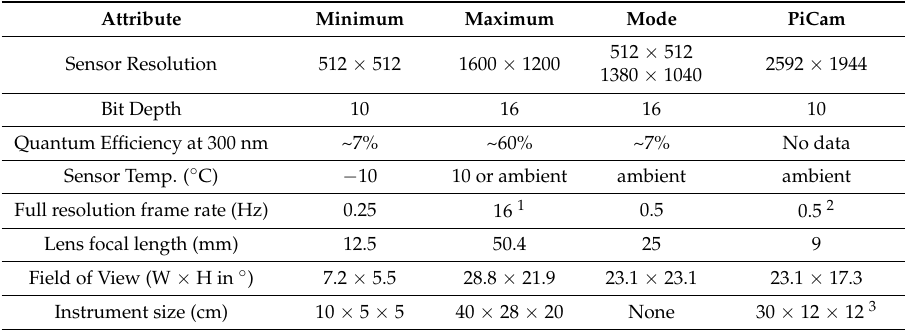
Table 1. A summary of key UV camera specifications from a previous inter-comparative study into the relative performance of seven such units, which have been applied in volcano monitoring [33]. For these seven systems, the maximum, minimum, and mode value of each parameter are supplied here, in addition to the corresponding datum for the